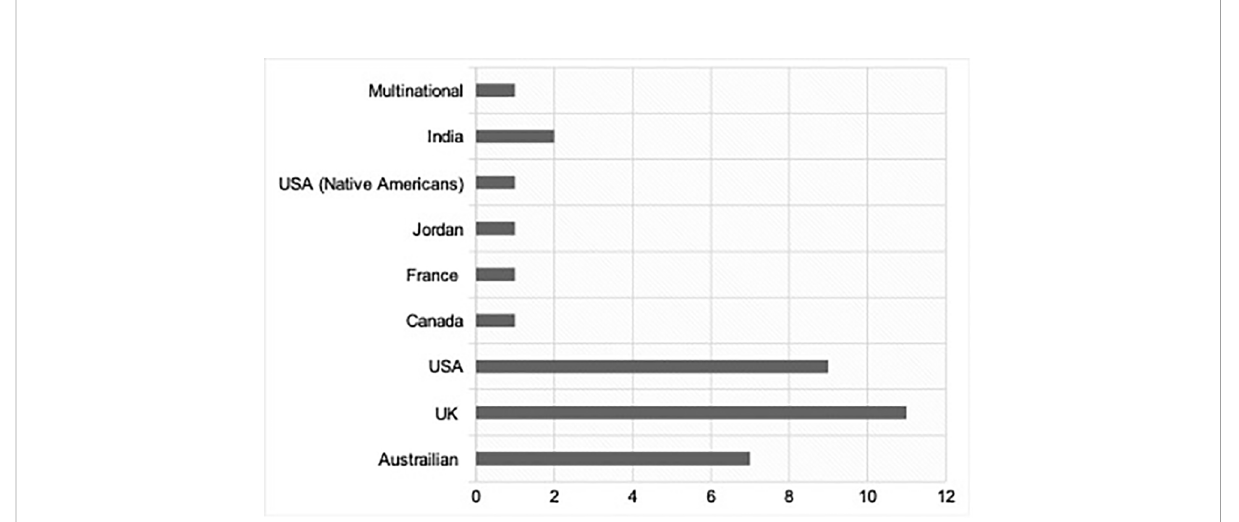
FIGURE 2 Chart displaying number of studies per country/ respective